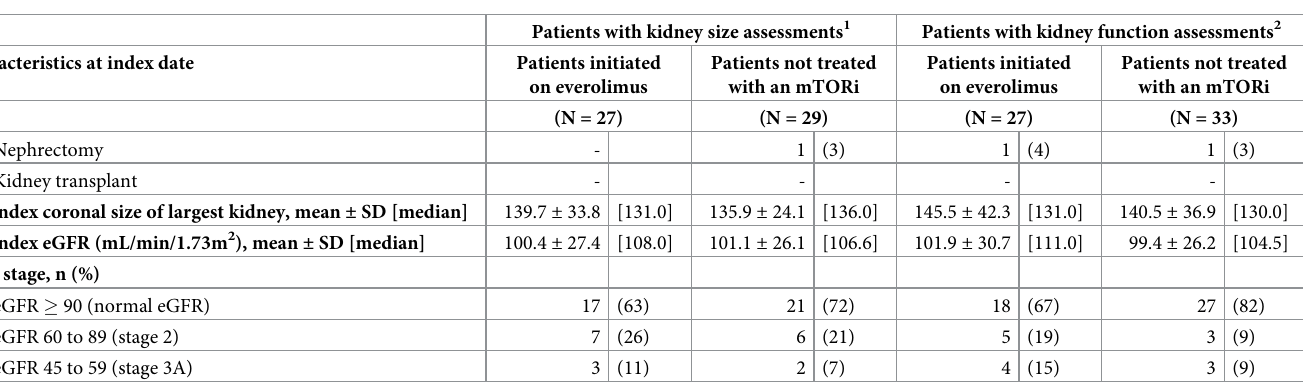
proportion of patients with a kidney size reduction was found between patients treated < 12 versus � 12 months (80.0% vs. 86.4%, p = 0.72).